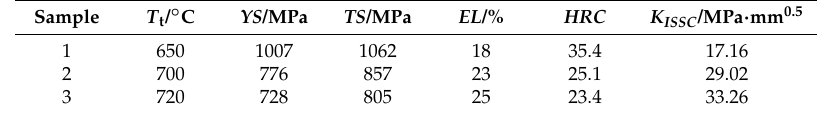
Summary of mechanical properties and K ISSC value for quenching and tempering (Q&T)–treated samples. YS : yield strength; TS : tensile strength; EL : elongation; HRC : hardness. Sample T t / ◦